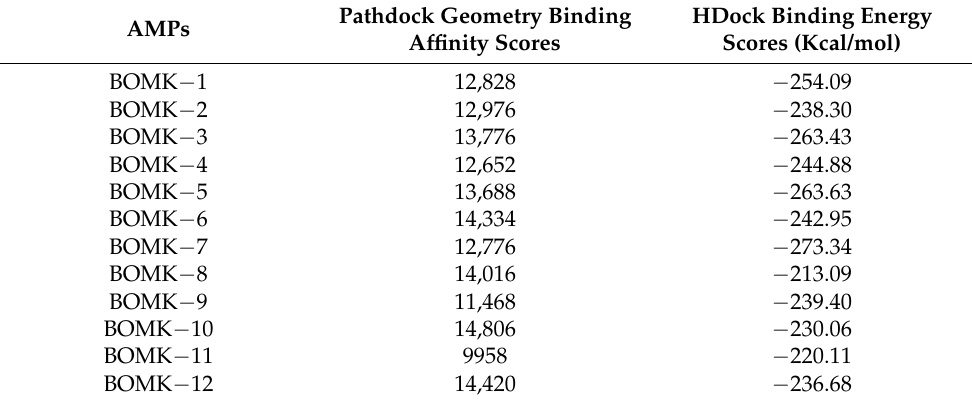
Figure 3. 3D structures of the anti-Fusarium oxysporum AMPs and Fusarium oxysporum PR-1-like protein, Fpr1, as determined by I-TASSER. 3D structures of anti-Fusarium oxysporum AMPs ( a – l ) represented in red and Fusarium oxysporum Fpr1 ( m ) represented in blue. Table 7. PATCHDOCK results for each AMPs and PR-1-like protein with the geometry binding affinity.